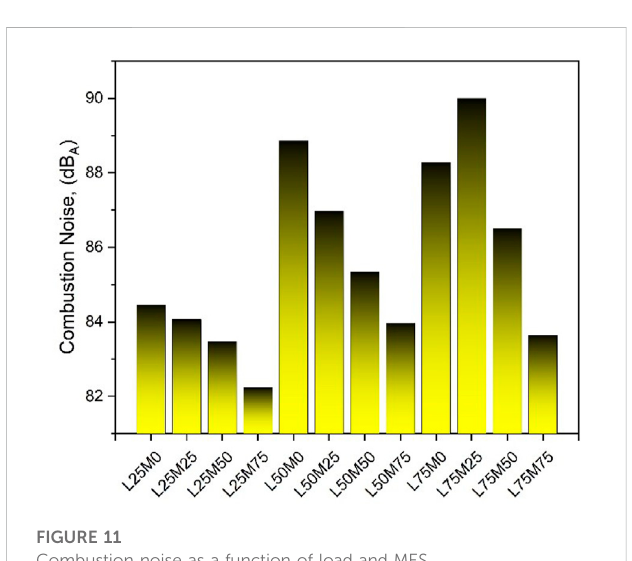
FIGURE 11 Combustion noise as a function of load and